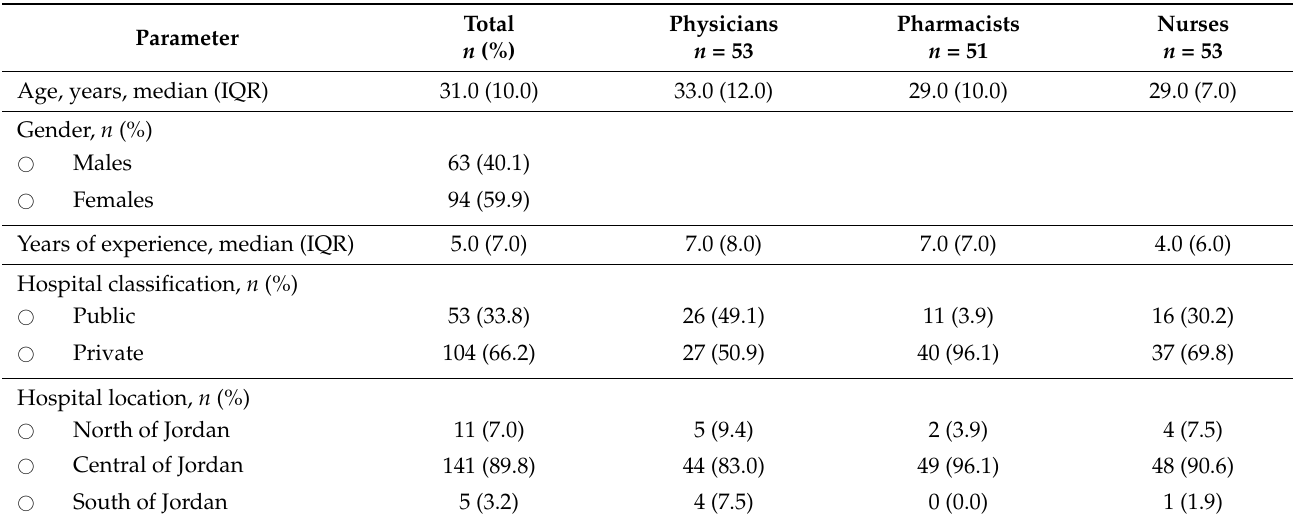
Table 1. Socio-demographic characteristics of the study sample ( n = 157).